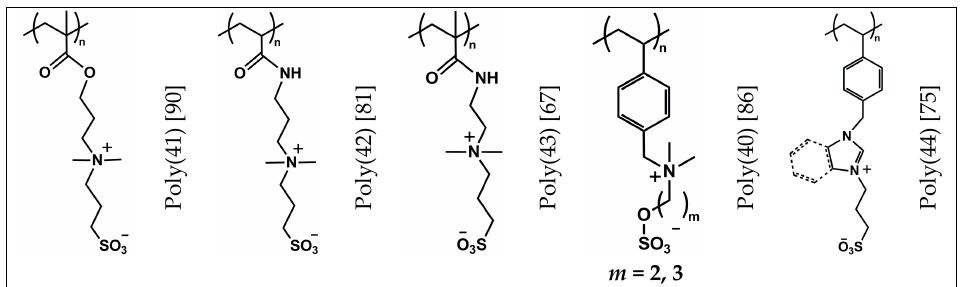
Figure 7. Structures of sulfobetaine zwitterionic polymers with UCST response.